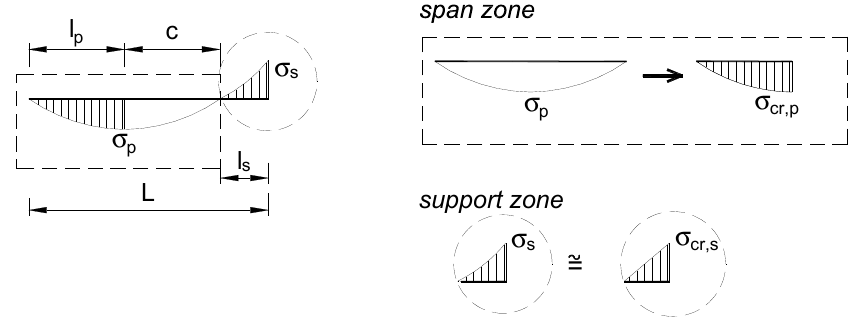
Figure 5. Calculation model of the first (end) span of a uniformly loaded continuous beam.